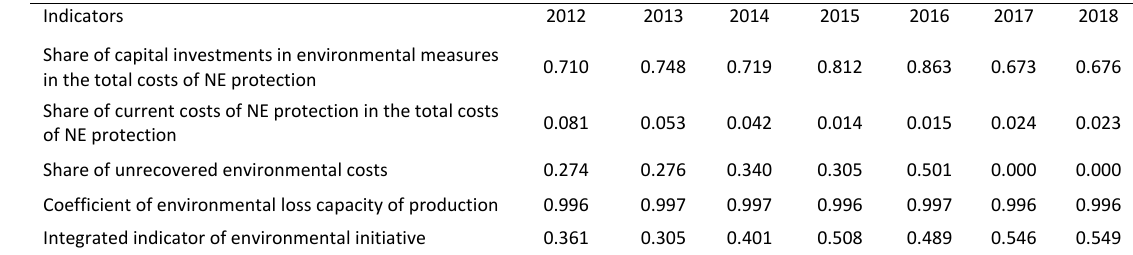
Table 5: Coefficients characterizing the level of environmental initiative of the enterprise under study for 2012–2018 Indicators